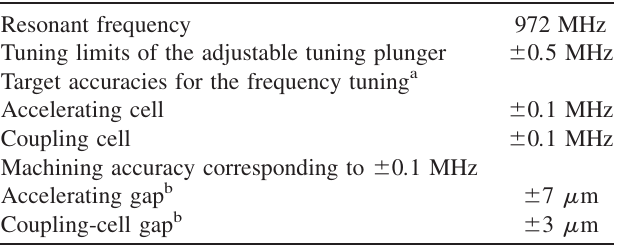
TABLE III. Required accuracies for the frequency tuning. Resonant frequency 972 MHz Tuning limits of the adjustable tuning plunger Target accuracies for the frequency tuning a